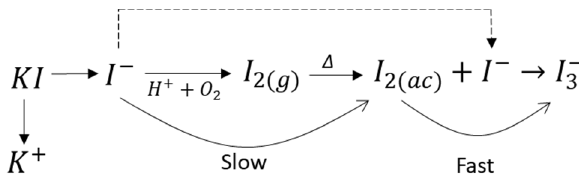
Figure 6. Schematization of the formation of the triiodide ion.